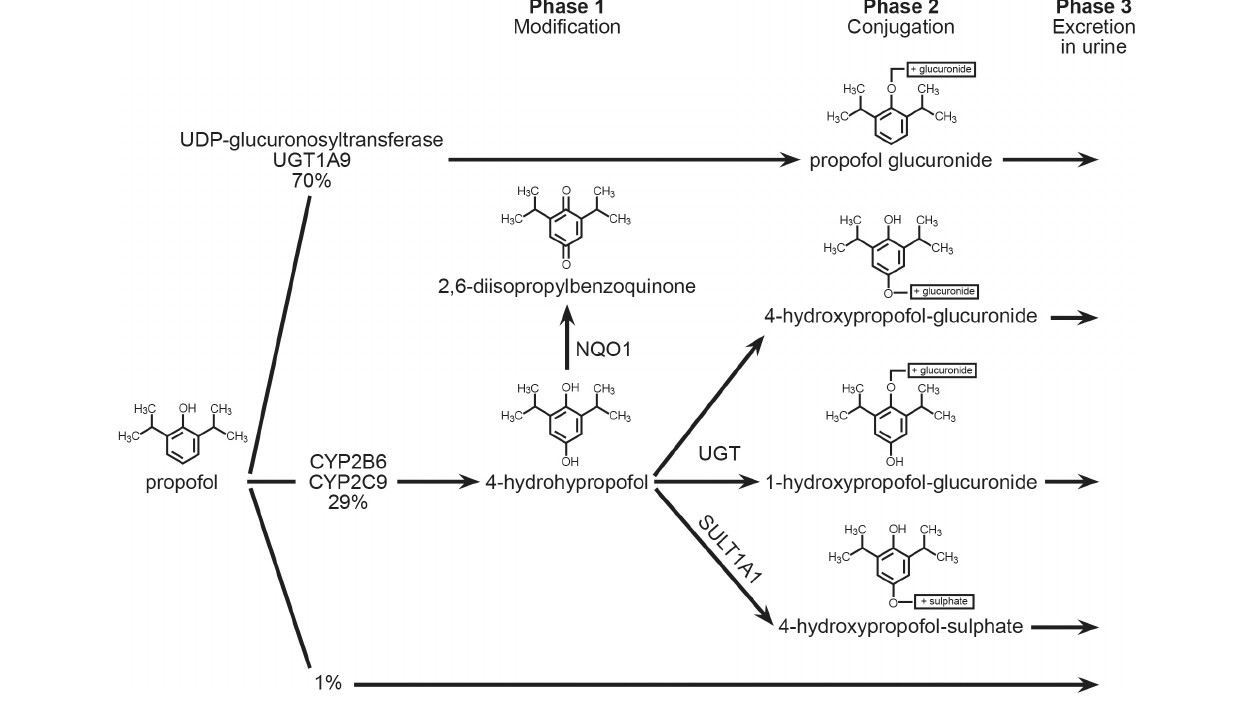
FIGURE 1 | Metabolic pathway of